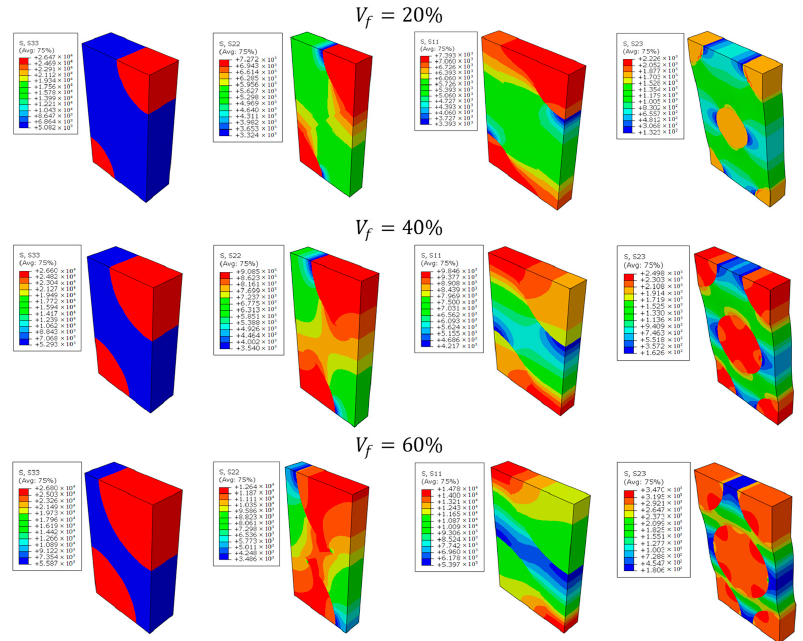
Figure 10. The stresses in RVE models with isotropic fiber approach for different volume fractions (in MPa).